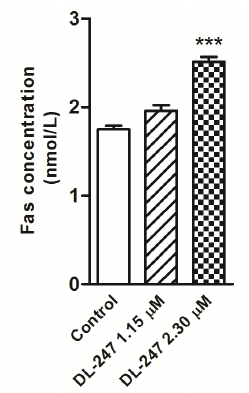
Figure 6. Changes in Fas concentration in HL-60 cells treated with DL-247 for 24 h analyzed by Human Fas ELISA kit. Data are presented as mean ± SEM of three independent experiments. Statistical significance was assessed using one-way ANOVA and a post-hoc multiple comparison Student–Newman–Keuls test. *** p < 0.001 vs. control.